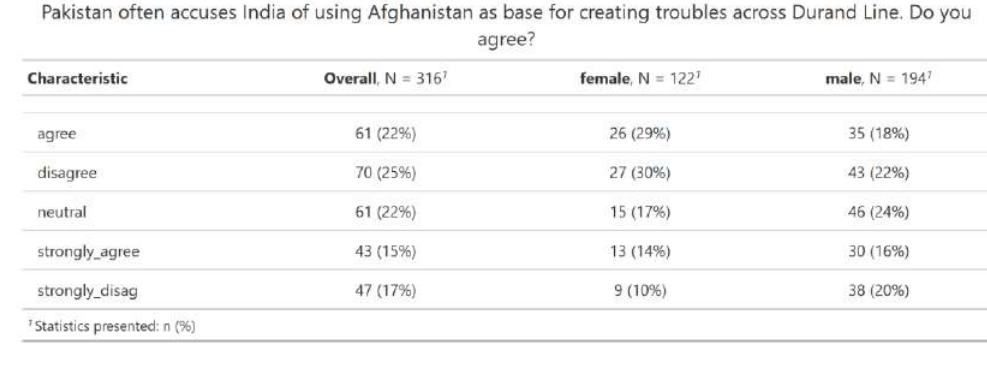
Table 32: Do you think India has come closer to Afghanistan under PM Narendra Modi?